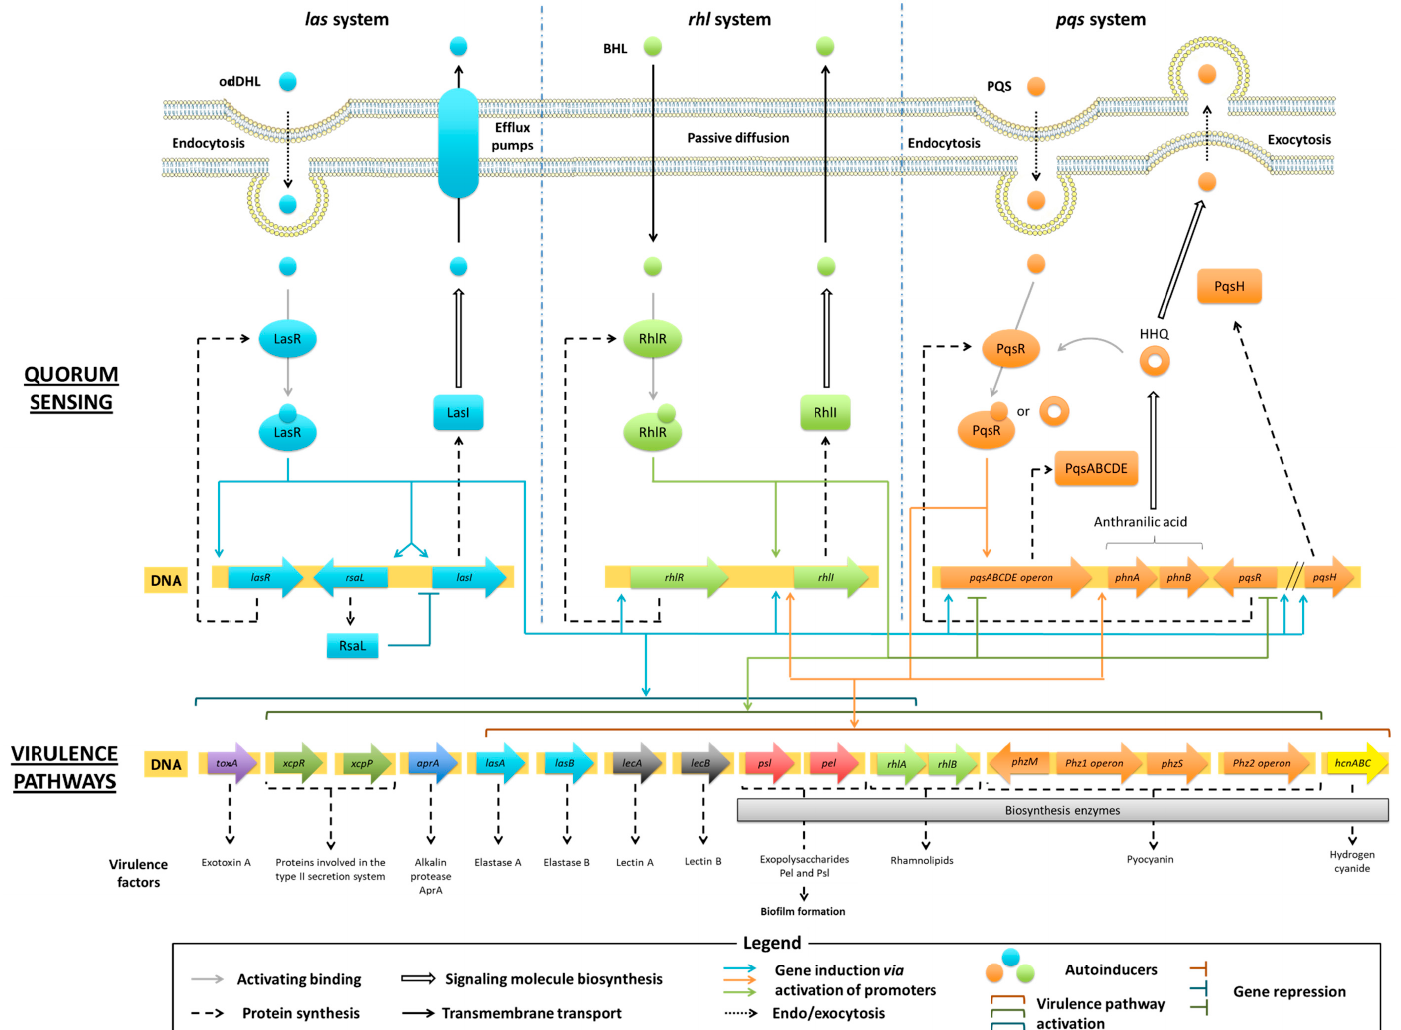
Figure 2. Interconnected QS networks of P. aeruginosa and regulation of virulence